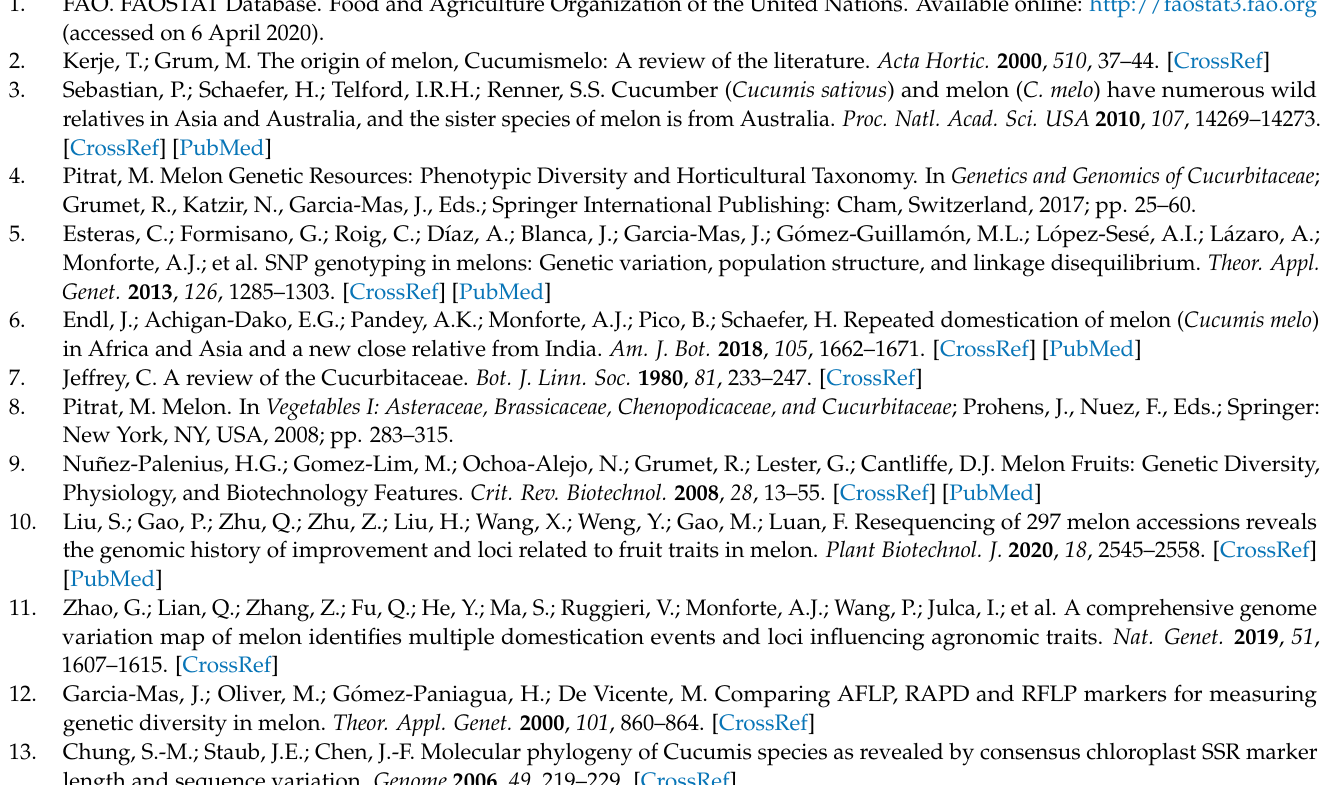
Table S4: Statistics of genetic variation for the makuwa cultivars and landraces, Table S5: Results of analysis of molecular variance (AMOVA) and F-statistics within the makuwa cultivars and landraces, Table S6: Pairwise distance between single nucleotide polymorphisms